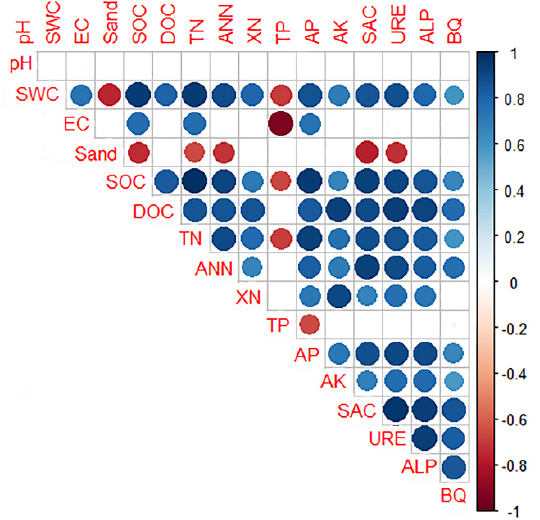
Figure 6. Correlations of soil physicochemical characteristics, nutrients, and enzyme activities. SWC: